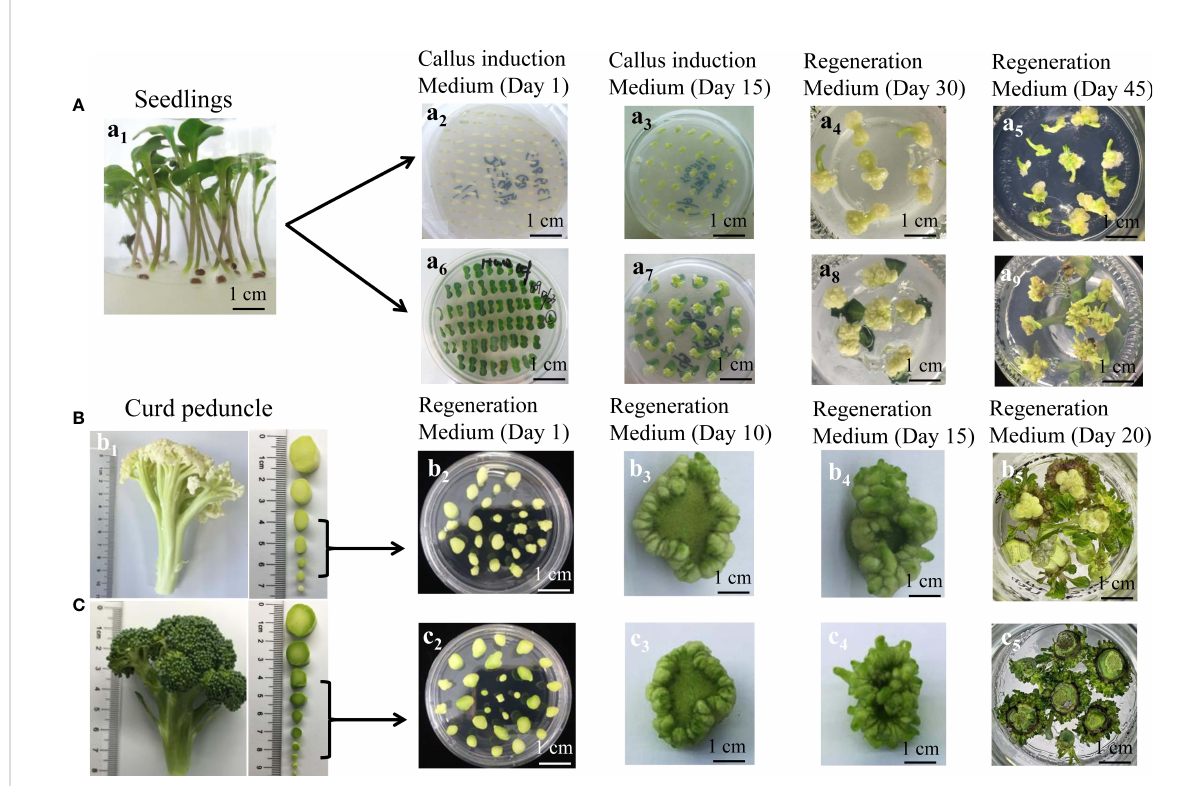
FIGURE 1 The shoot regeneration from different explants of C90IL-9 and B80IL-2. (A) shoot regeneration from hypocotyl and cotyledon petiole explants of C90IL-9. (A1), seedlings grown on sterile medium for 6 d after seed sterilization, Calli induction and shoot regeneration from hypocotyl (A2- 5) and cotyledon petiole (A6-9) from day 1 to day 45. (B) and (C) shoots directly regenerated from curd peduncle explants. A branch from a mature curd of C90IL-9 (B1) and B80IL-2 (C1), respectively, and the peduncles with cross-sectional diameter of 0.3-0.8 cm were selected for